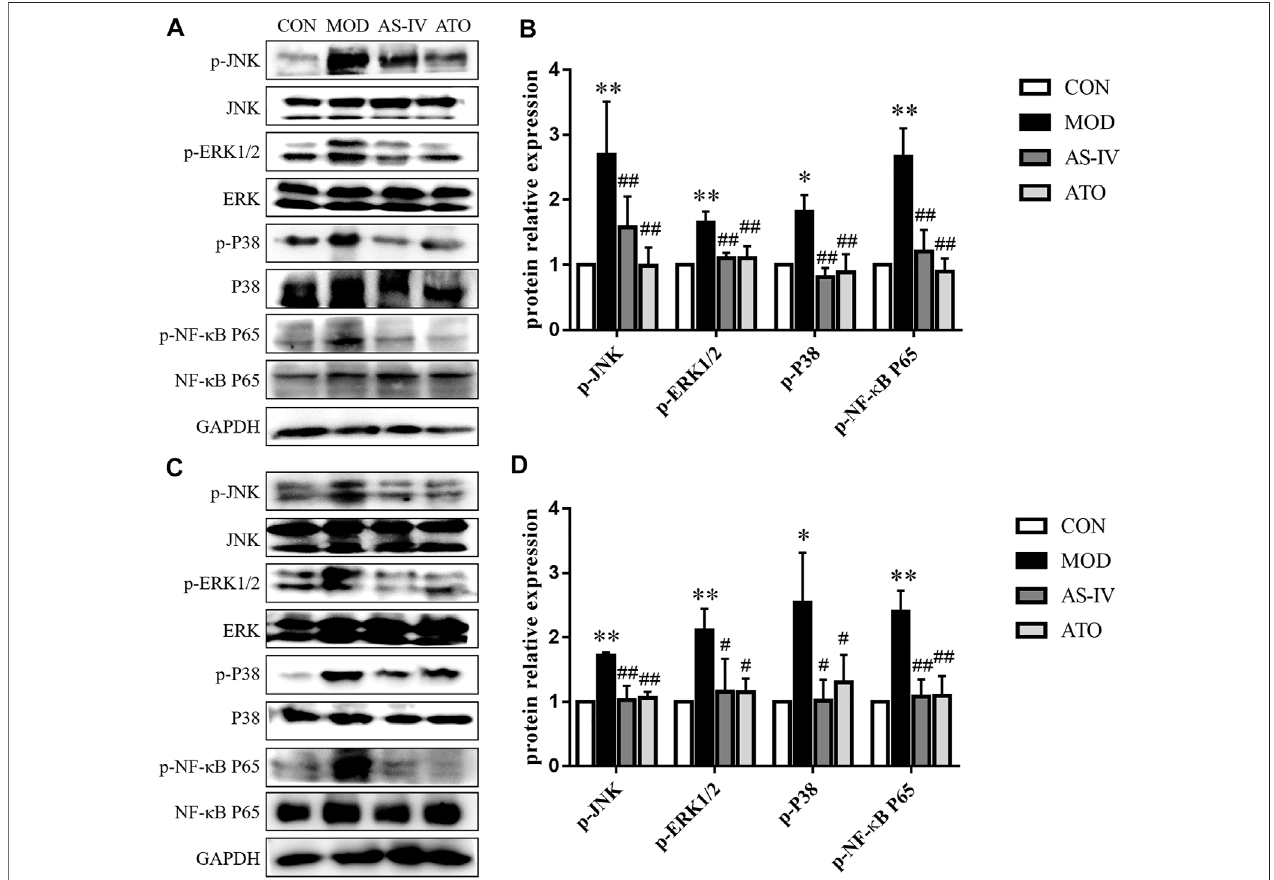
FIGURE5| MAPKssignalingpathwayintheLDLR − / − mice.Proteinwasextractedfrommiceaorta (A) andlivertissue (C) .Thenthetotalandphosphorylatedlevels of JNK, ERK1/2, p38 and NF- κ B P65 were determined by western blotting assay, n = 3. (B,D) The quantitative results were depicted. CON means control group, MOD meansmodelgroup,AS-IVmeansAstragalosideIVgroup,ATOmeansAtorvastatingroup.Dataareexpressedasmean±SD.** p < 0.01versusCONgroup;## p < 0.01 versus MOD